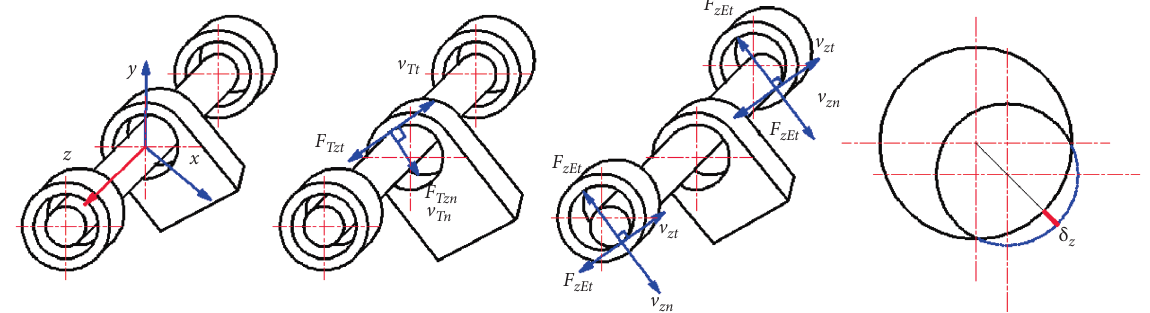
Blue indicator lines are in the xy plane Figure 3: Contact process of the single independent clearance point